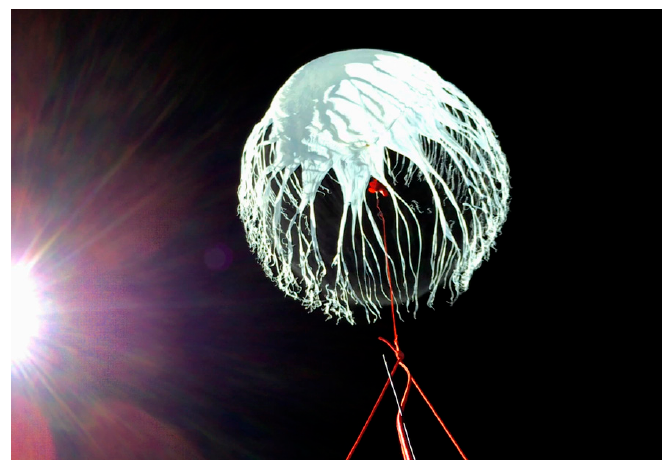
Figure 2. Burst of the balloon, as captured by the onboard camera.